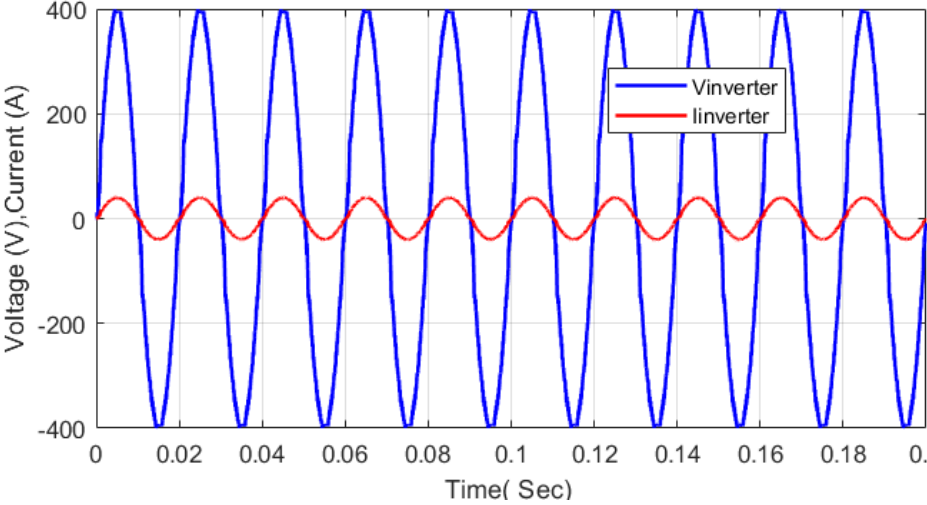
Figure 28. Output voltage and current of the proposed topology after minimal filtering.